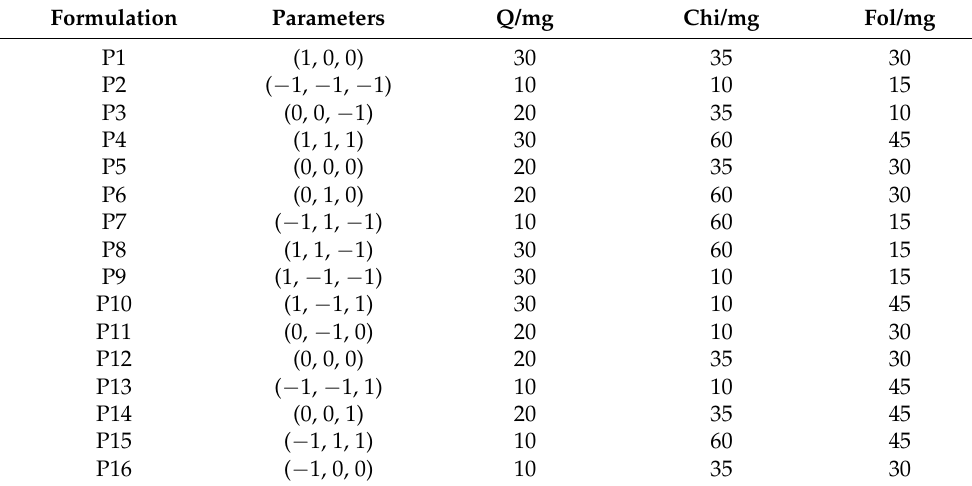
Table 1. Formulations generated by JMP software with varying amounts of quercetin (Q), chitosan (Chi), and folic acid